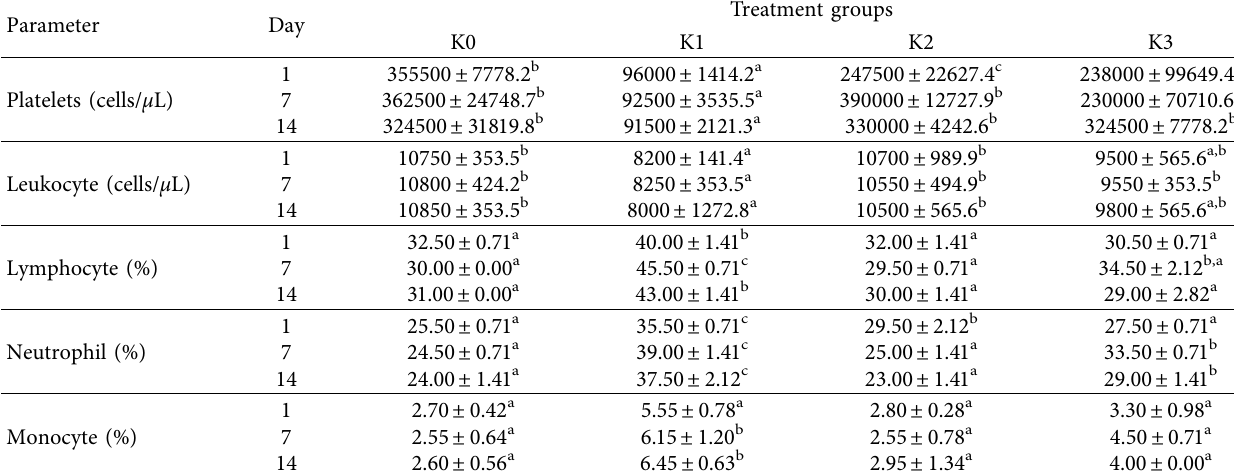
Table 2: Results of rat’s blood haematology